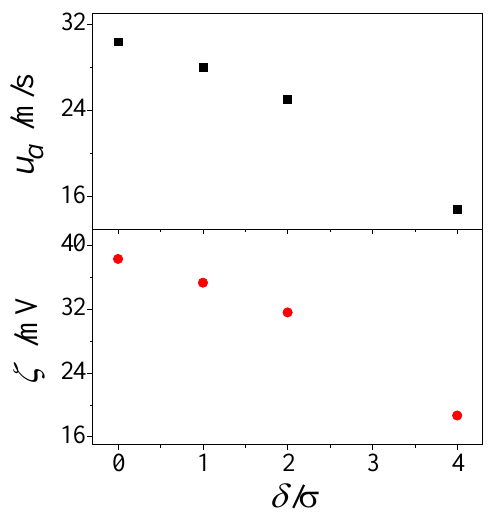
Figure 9. Effect of roughness height on electroosmotic flow.